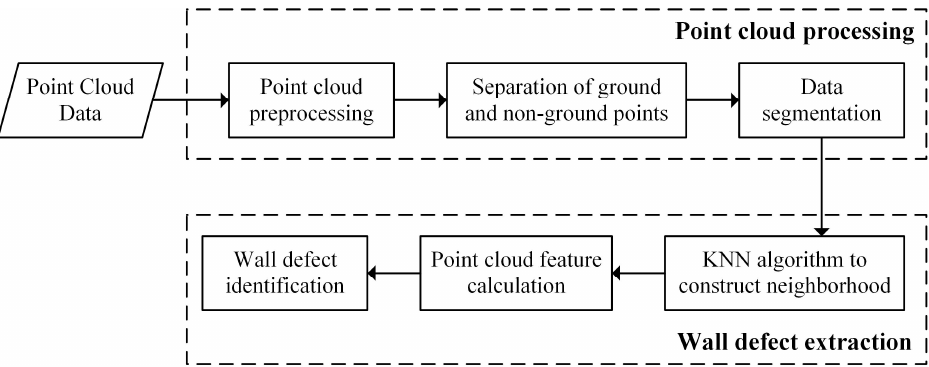
Figure 11. Flow chart of point cloud data for wall defect extraction.